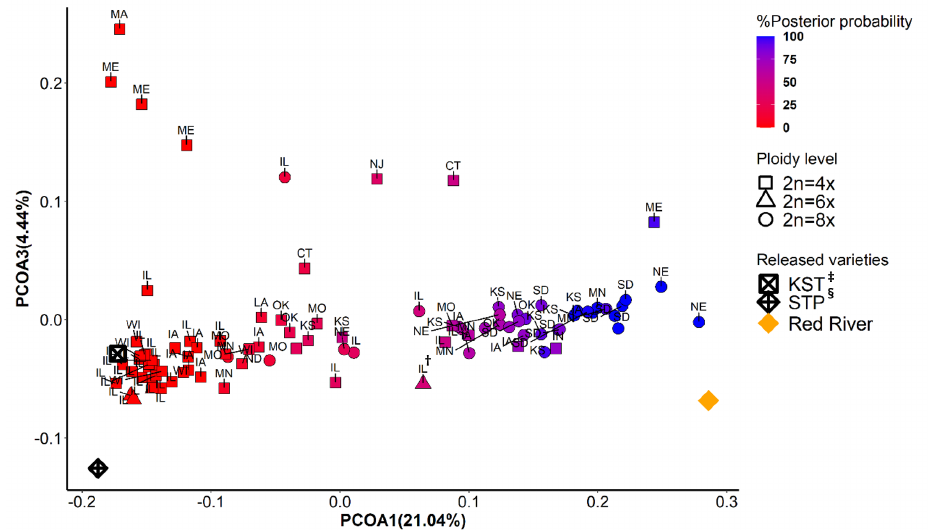
Figure 3. Principal coordinate analysis using 9315 SNPs data. The scores from the first (PCOA1) and the second (PCOA3) were plotted on x - and y -axis, respectively. The populations were colored in a gradient scale based on the posterior of probability assigned to two genetic groups inferred from fastStructure and DAPC . Shapes correspond to three levels of ploidy. † : A hexaploid popu- lation collected from Illinois; ‡ : KST = Kingston germplasm, Big Flats plant material center,